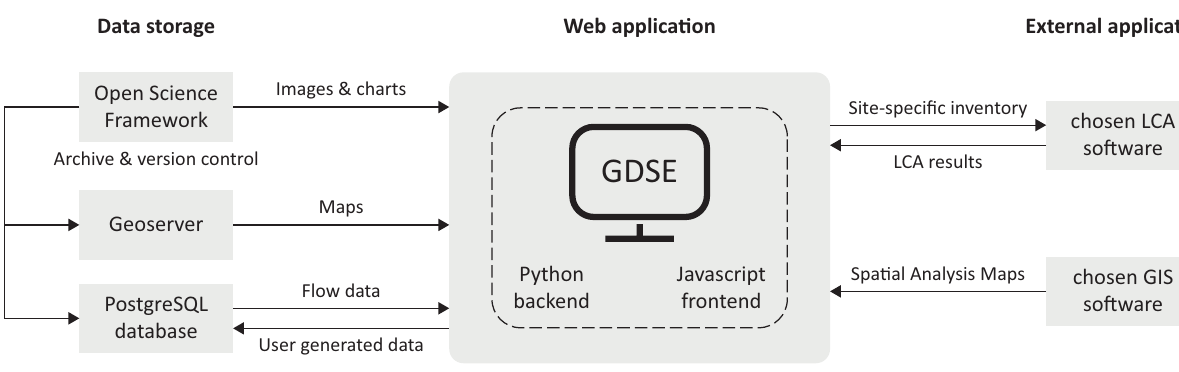
Figure 5. Integrating open source components into a single GDSE. Source: